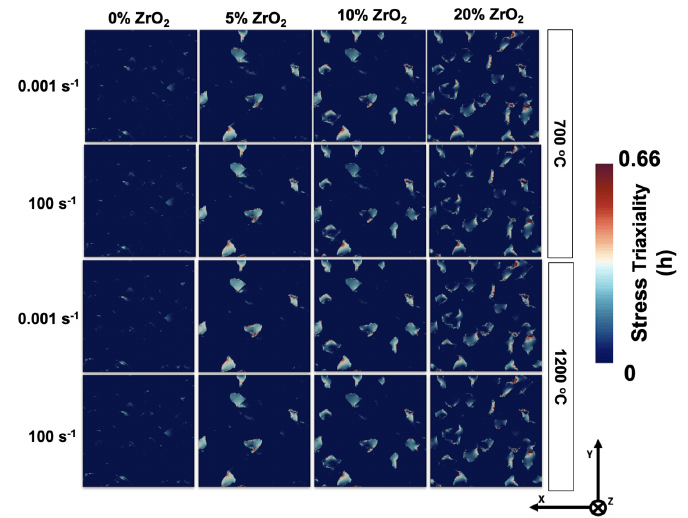
Figure 13. Triaxial local stress maps at 700 and 1200 °C, 0.1 true strain, and 0.001 and 100 s –1 strain rate.